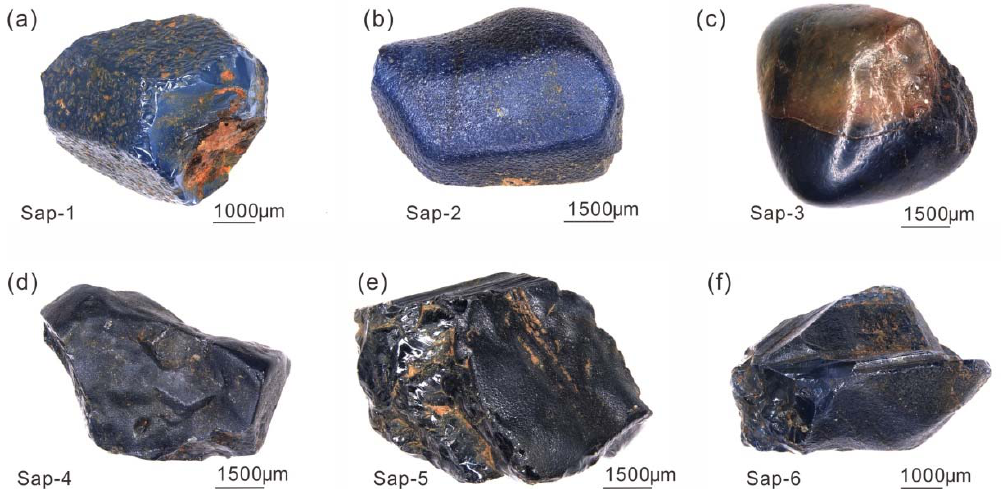
Figure 2. Six raw sapphire samples from the Penglai alluvial deposit: ( a ) Sap-1; ( b ) Sap-2; ( c ) Sap-3; ( d ) Sap-4; ( e ) Sap-5; ( f ) Sap-6. Sap-1 shows a trapezoid-shaped dark-blue core rimmed by lightly yellowish-brown diffuse-zoned bands (Figure 3a), sap-2 has distinct colored parallel bands in various widths (Figure 3b), sap-3 has both yellow and blue colors (Figures 2c and 3c), sap-4 has evenly dark-blue patch in the core rimmed by light blue edges (Figure 3d), sap-5 has obvious streaks on the surface (Figure 2e), and sap-6 has a hexagonal pyramid-shaped in the core (Figure 2f).